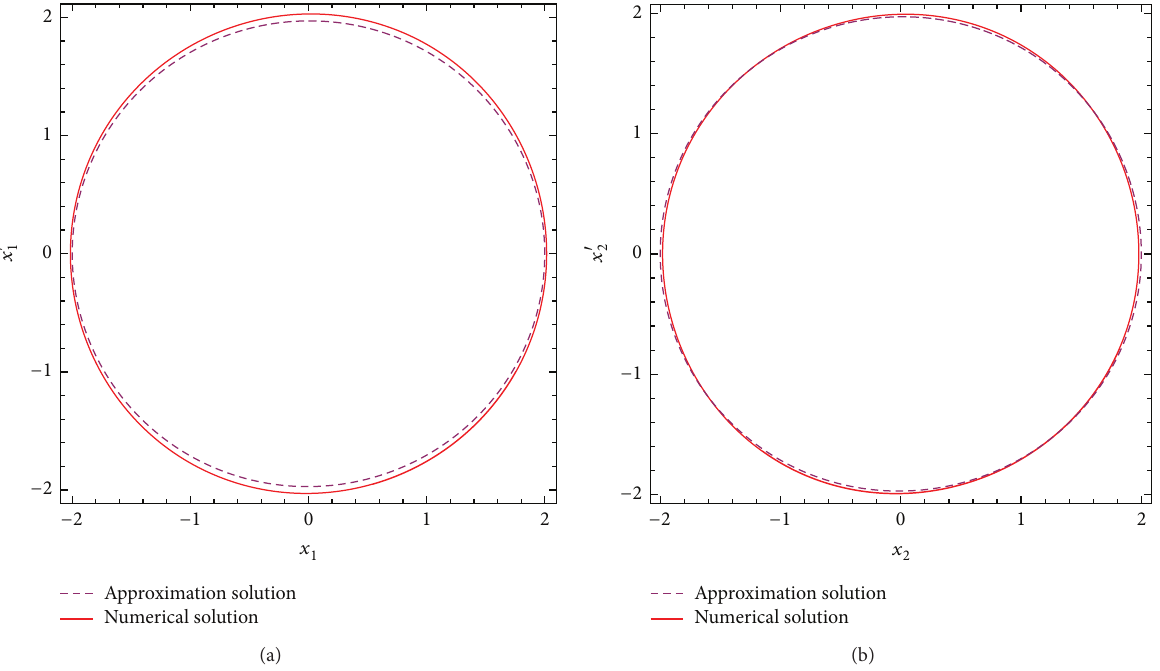
Figure 2: Comparison between the phase curves of the fifth-order approximation and the numerical integration out-of-phase solution.